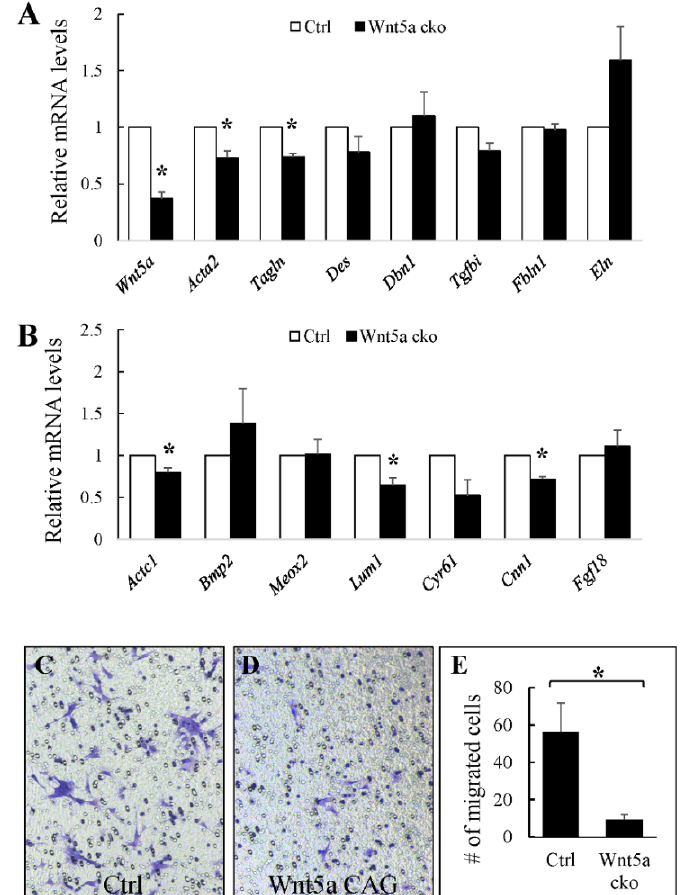
Figure 6. Inactivation of Wnt5a in vitro disrupts differentiation and migration of cultured fibroblasts. Fibroblasts from P5 neonatal lungs were isolated, cultured and treated with tamoxifen (1.5 µ g / mL) for 24 h before RNA isolation. A : Relative mRNA for myofibroblasts-enriched genes in Wnt5a CAG fibroblasts compared to control lung fibroblasts determined by real-time RT-PCR analysis. B : Relative mRNA of cell migration genes in Wnt5a CAG fibroblasts compared to control lung fibroblasts determined by real-time RT-PCR analysis. Data represent the mean ± SEM. * indicates p < 0.05. n = 4. C – D : Transwell migration assay. Control ( C ) and Wnt5a CAG ( D ) fibroblasts treated with tamoxifen (1.5 µ g / mL, 24 h) were plated on 12-micron Transwell membranes and cultured for 24 h. Cells migrated to the lower side of the Transwell were stained with crystal violet and counted. E : Quantification of the number of cells that migrated to the lower side in unit area. Four areas from each experiment (each Transwell) were imaged, counted and the means calculated. Date represent the mean of three independent experiments ± SEM. * indicates p < 0.05.